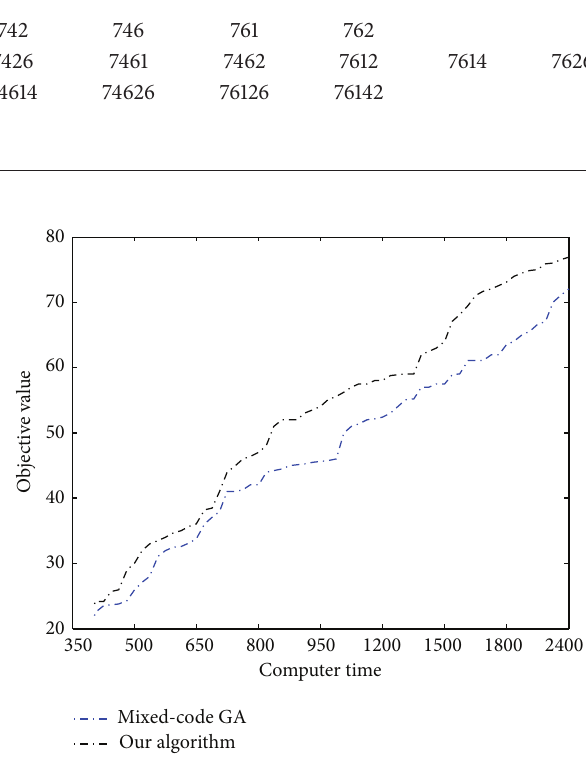
Figure 6: Average objective values of two